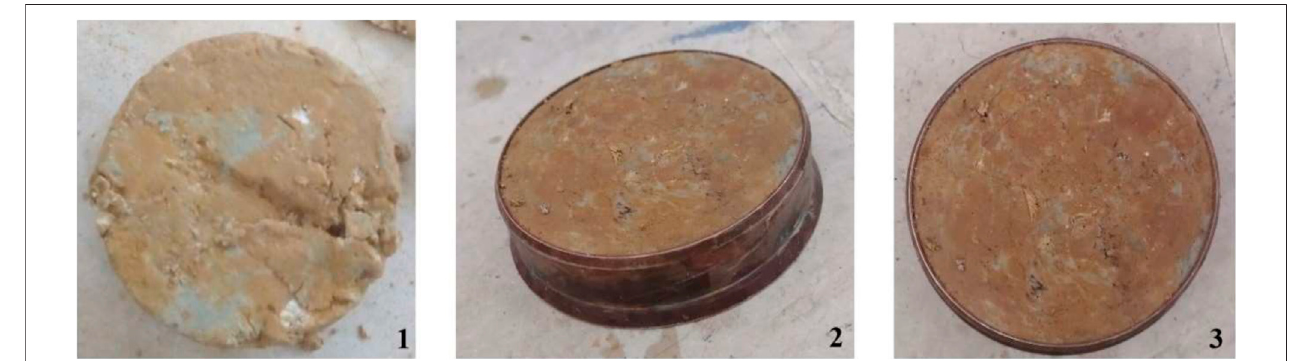
FIGURE 11 | Disturbed clay sample, S1 sample.